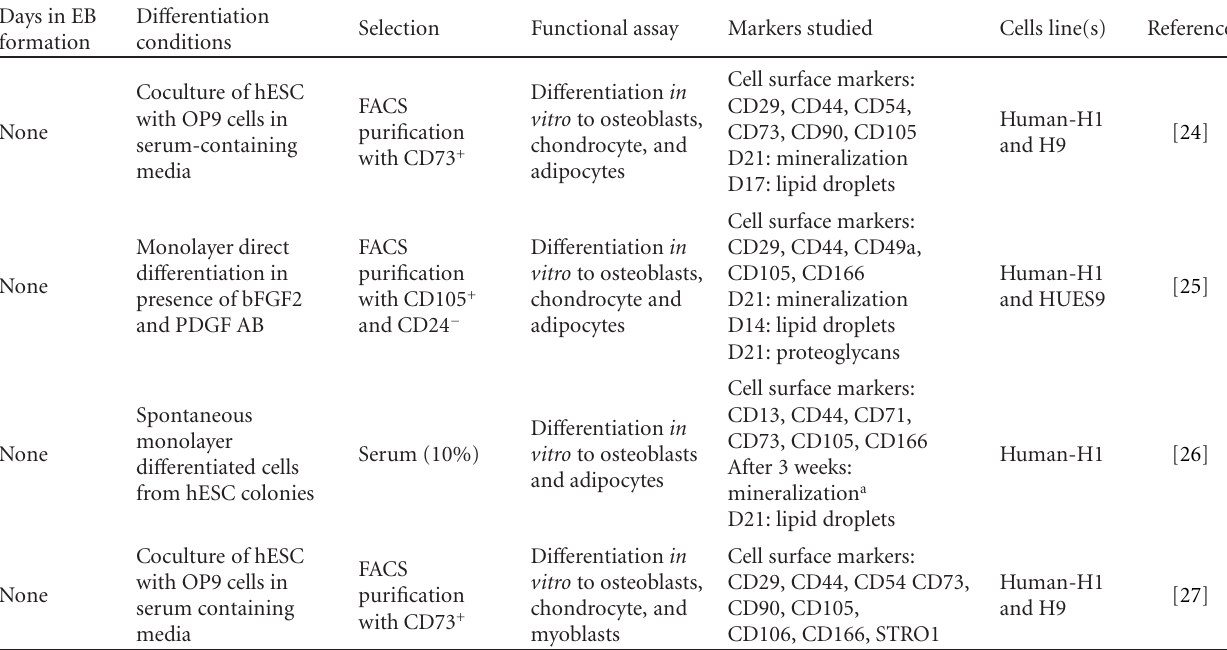
Table 2: Models for di ff erentiation of embryonic stem cells into multipotent mesenchymal stem cells. Days in